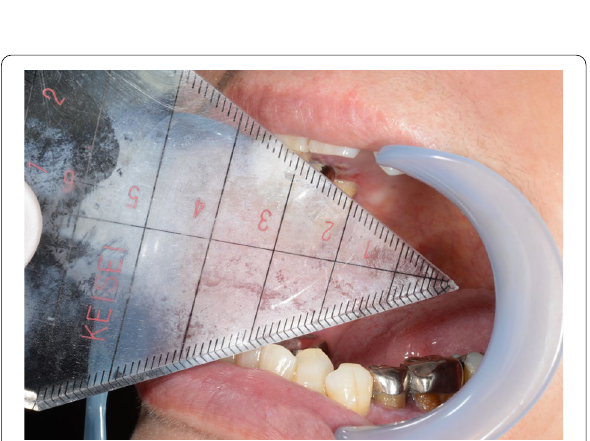
Fig. 2 Preoperative measurement photograph. The patient’s maximum mouth opening distance was approximately 30